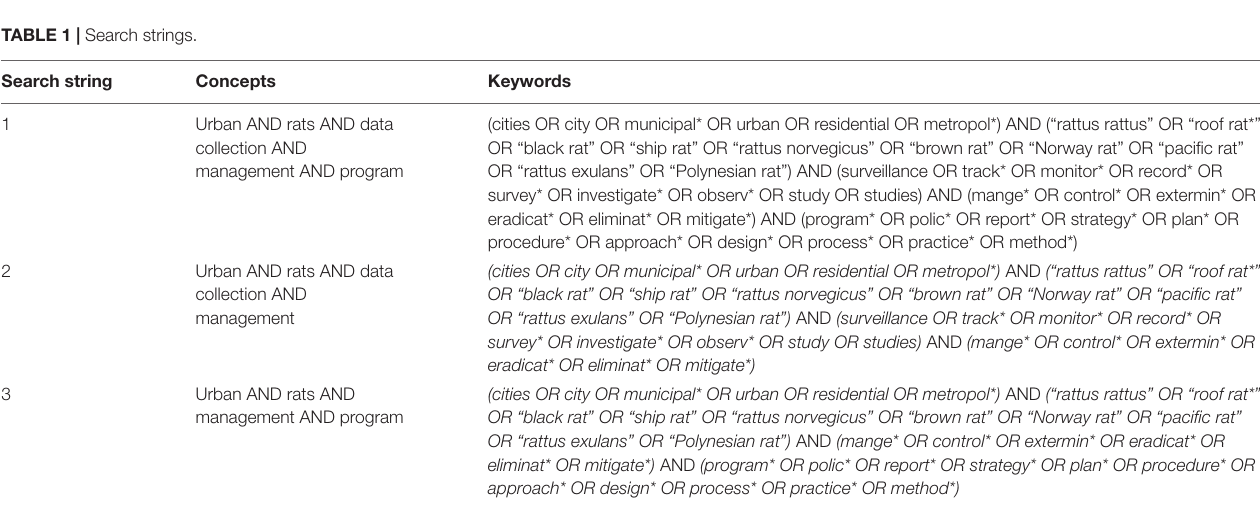
FIGURE 1 | Overall search strategy. The overall search strategy consisted of five components to maximize the breadth of literature found. Initial searches were carried out by co-author SI. A secondary review of publications found by SI was carried about by the first author (MJL). A total of 129 publications were included for narrative review and